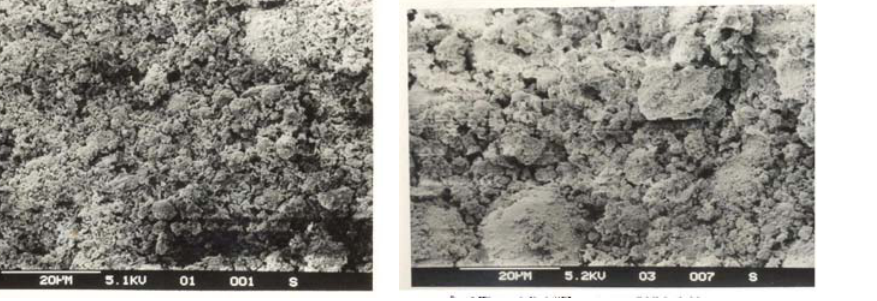
Figure 9. SEM micrograph of leached LFAS composite containing nickel hydroxide